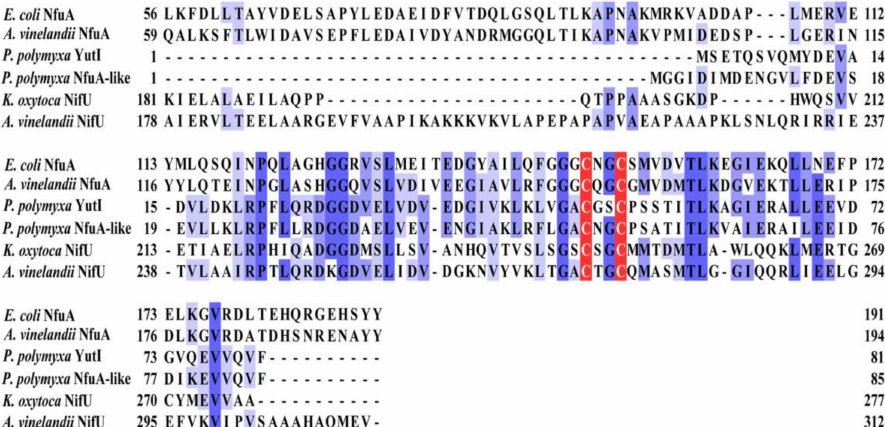
Figure 4. Comparison of NifU-like proteins (YutI and NfuA-like) from P. polymyxa , NifU from A. vinelandii , NifU from K. oxytoca , and NfuA from E. coli . Protein sequences were aligned using the Clustal Omega program (https://www.ebi.ac.uk/Tools/msa/clustalo/, accessed on 25 March 2021). Conserved CXXC motifs are highlighted with a red background.